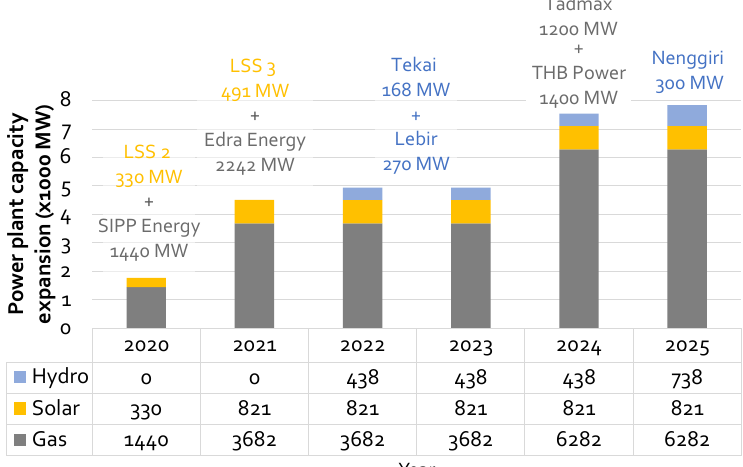
Figure 9. Malaysia power plant capacity expansion plan till 2025